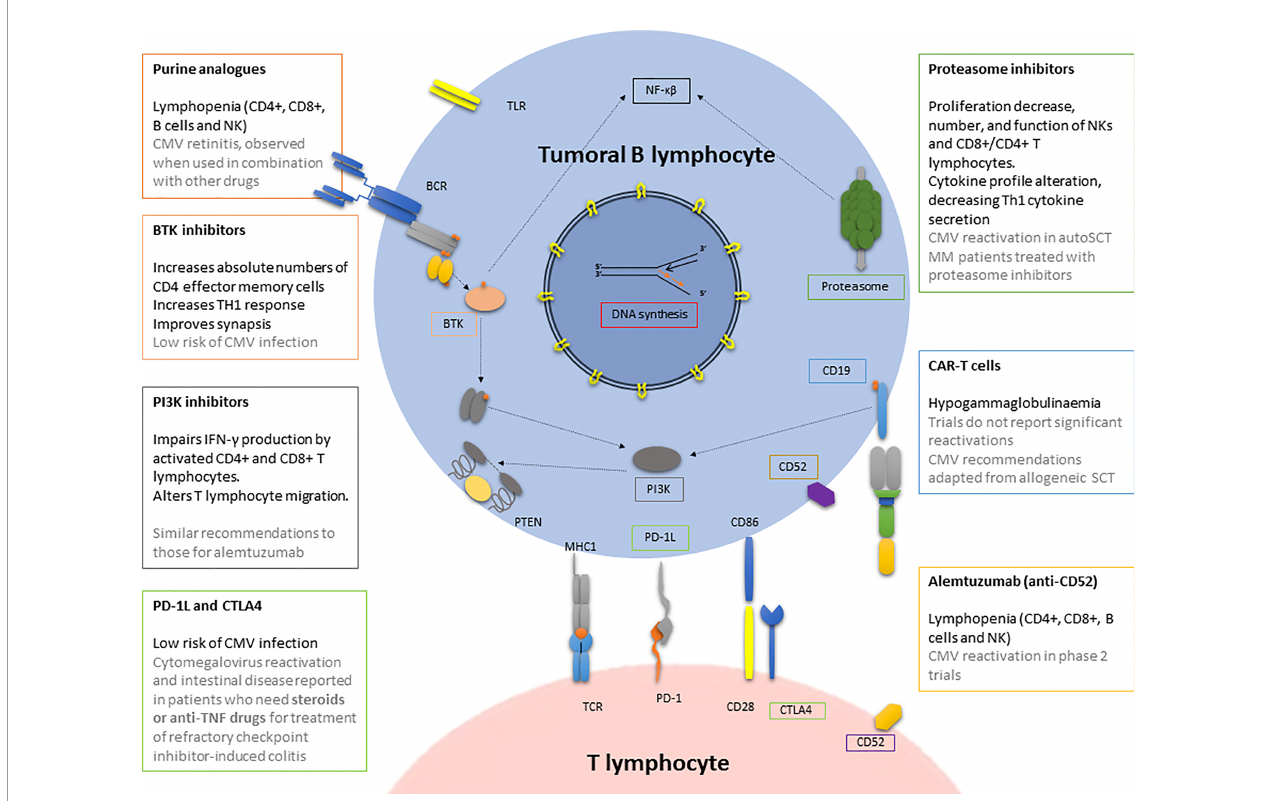
FIGURE 2 | CMV infection/reactivation in the context of antitumoral drugs used in haematological patients. BCR, B cell receptor; BTK, Bruton tyrosine kinase; CAR- T cells, chimeric antigen receptor T cell; CMV, cytomegalovirus; CTLA4, cytotoxic T-lymphocyte antigen 4; MHC, major histocompatibility complex; NK, natural killer; PI3K, phosphatidyl inositol 3 kinase; PD, programmed death; PD-1L, programmed death-ligand 1; PTEN, phosphatase and tensin homologue; SCT, stem cell transplantation; TLR, toll-like